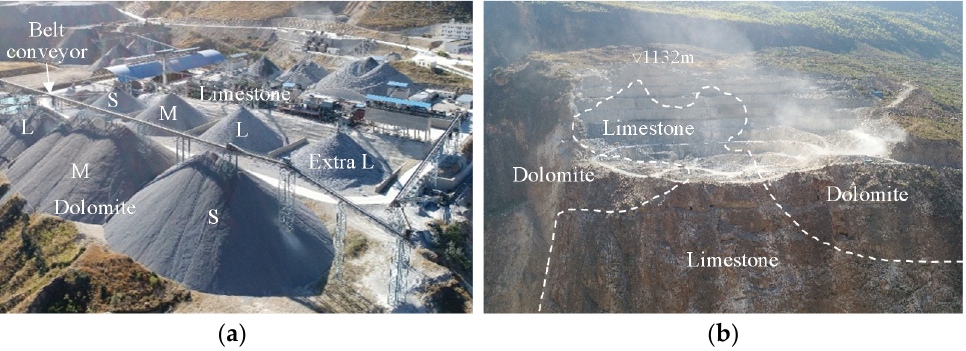
Figure 1. Shiqi aggregate system at WDD hydropower station: ( a ) Shiqi aggregate field; ( b ) Shiqi aggregate production system (Note: L is the large stone, M is the medium stone, S is the small stone, Extra L is the extra-large stone).